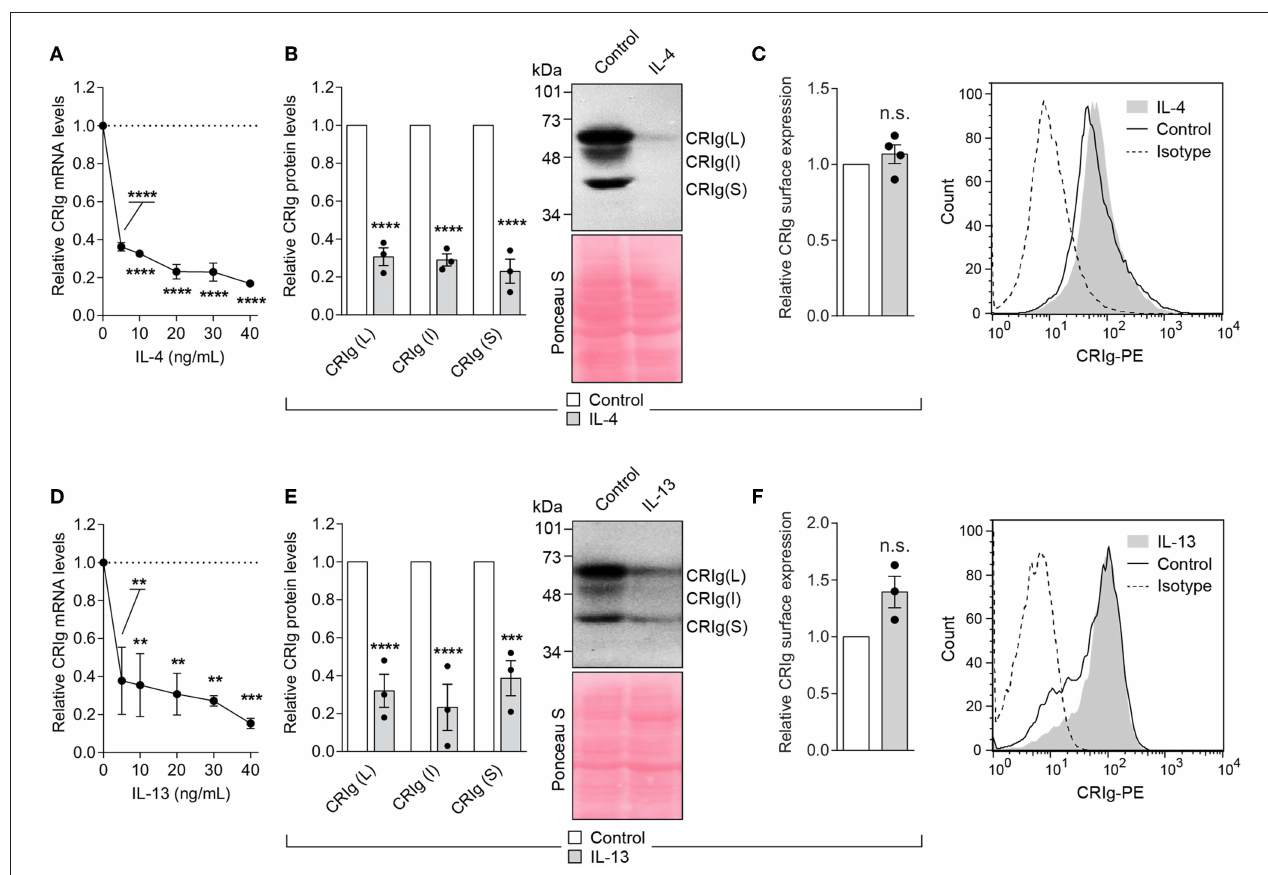
FIGURE 4 | IL-4 and IL-13 down regulate CRIg expression in DC. (A,D) DC were treated with a dose range of the cytokines for 24h and then examined for CRIg mRNA expression. (B,E) The levels of total CRIg isoform proteins measured by Western blot in DC treated with 20ng/ml of cytokines. (C,F) Similarly treated DC were examined for surface expression of CRIg by flow cytometry. Data are presented as means ± SEM of at 3–4 experiments, each conducted with cells from a different individual. Significance levels are indicated by asterisks: ** P < 0.01, *** P < 0.001, **** P < 0.0001, whilst n.s. indicates